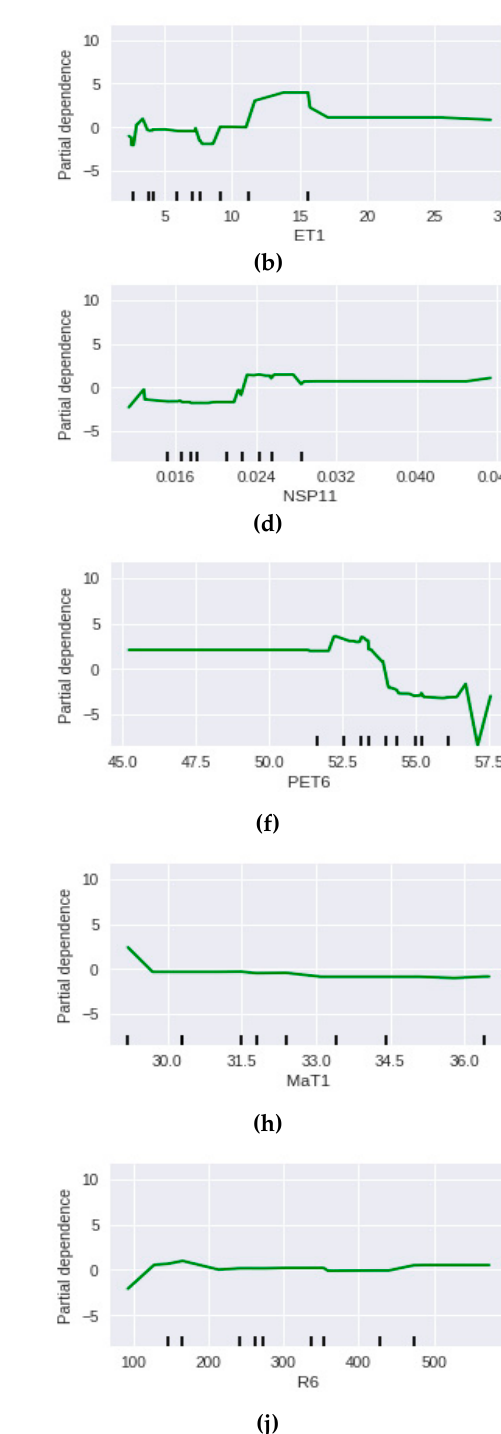
Figure 6. Partial dependence plots for 10 most important features (Gradient Boosted Regression).